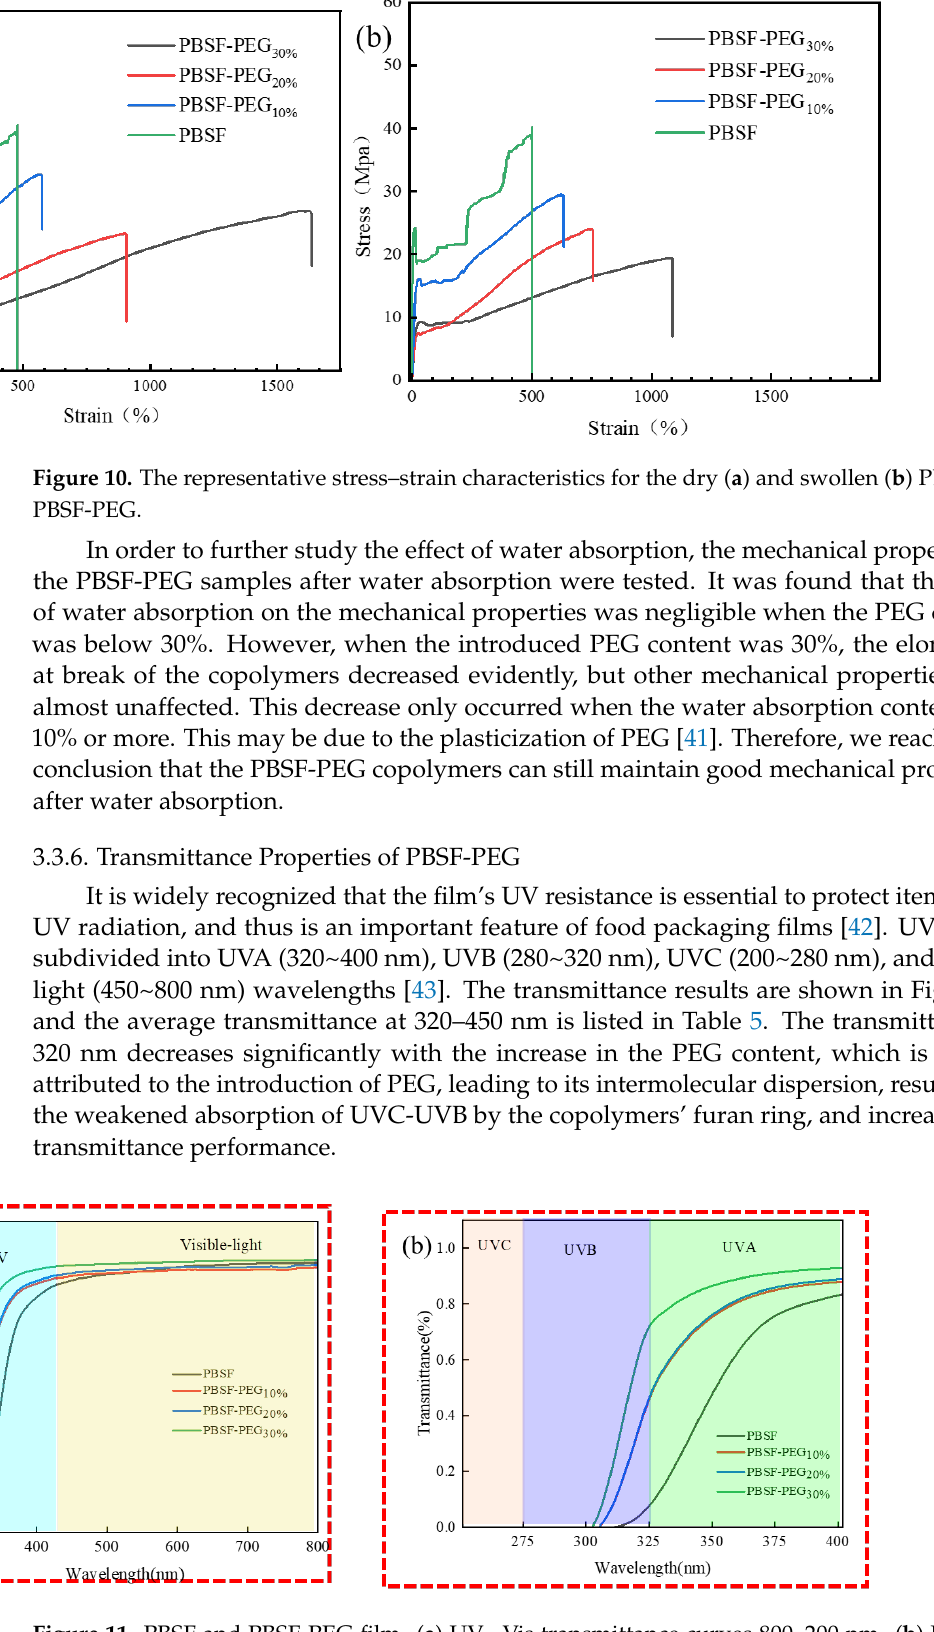
Figure 11. PBSF and PBSF-PEG film. ( a ) UV−Vis transmittance curves 800 – 200 nm. ( b ) UV − Vis transmittance curves 400 – 200 nm. Table 5. UV – Vis transmittance values at maximum UV-blocking wavelength of the polyester films.